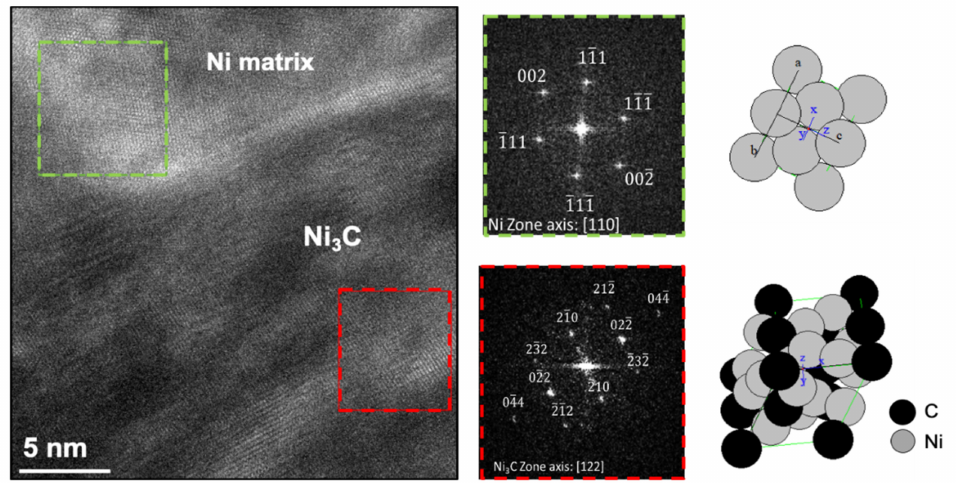
Figure 7. HRTEM image of Ni-CNT nanocomposite and FFT images of the two marked regions, indicating the presence of second phase particles indexed as Ni 3